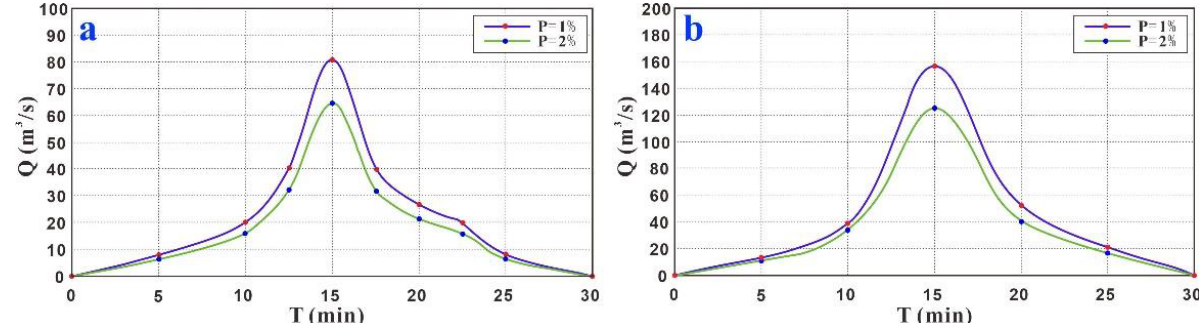
Figure 6. Flood hygrographs of water ( a ) and debris flow ( b ) under different return-period rainfalls in the Boshuigou debris flow simulation.